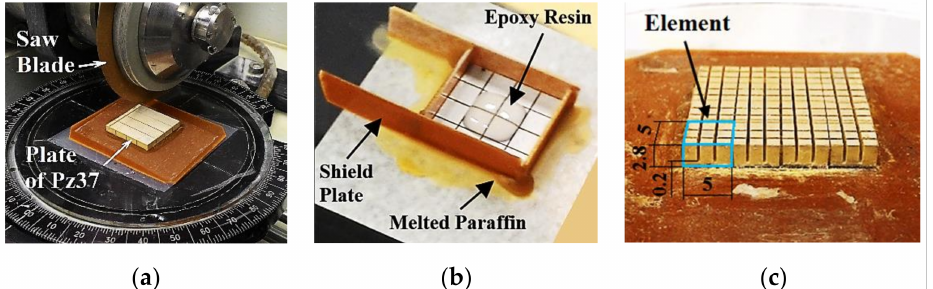
Figure 6. ( a ) The 4 × 4 array was made dicing the Pz37 plate in orthogonal directions at steps of 5.2 mm ( b ) and the kerfs were filled with epoxy resin. ( c ) 1–3 piezocomposite elements with nine pillars were made repeating the dice-and-fill technique with kerfs at steps of 1.73 mm. A single element is outlined in blue.